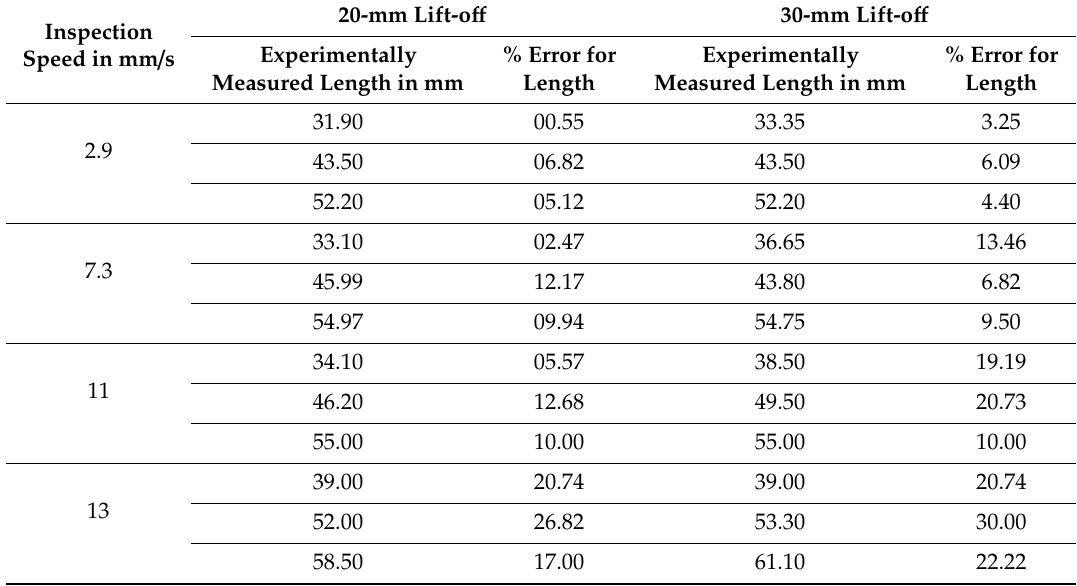
Table 5. Percentage error for 20-mm and 30-mm lift-o ff .